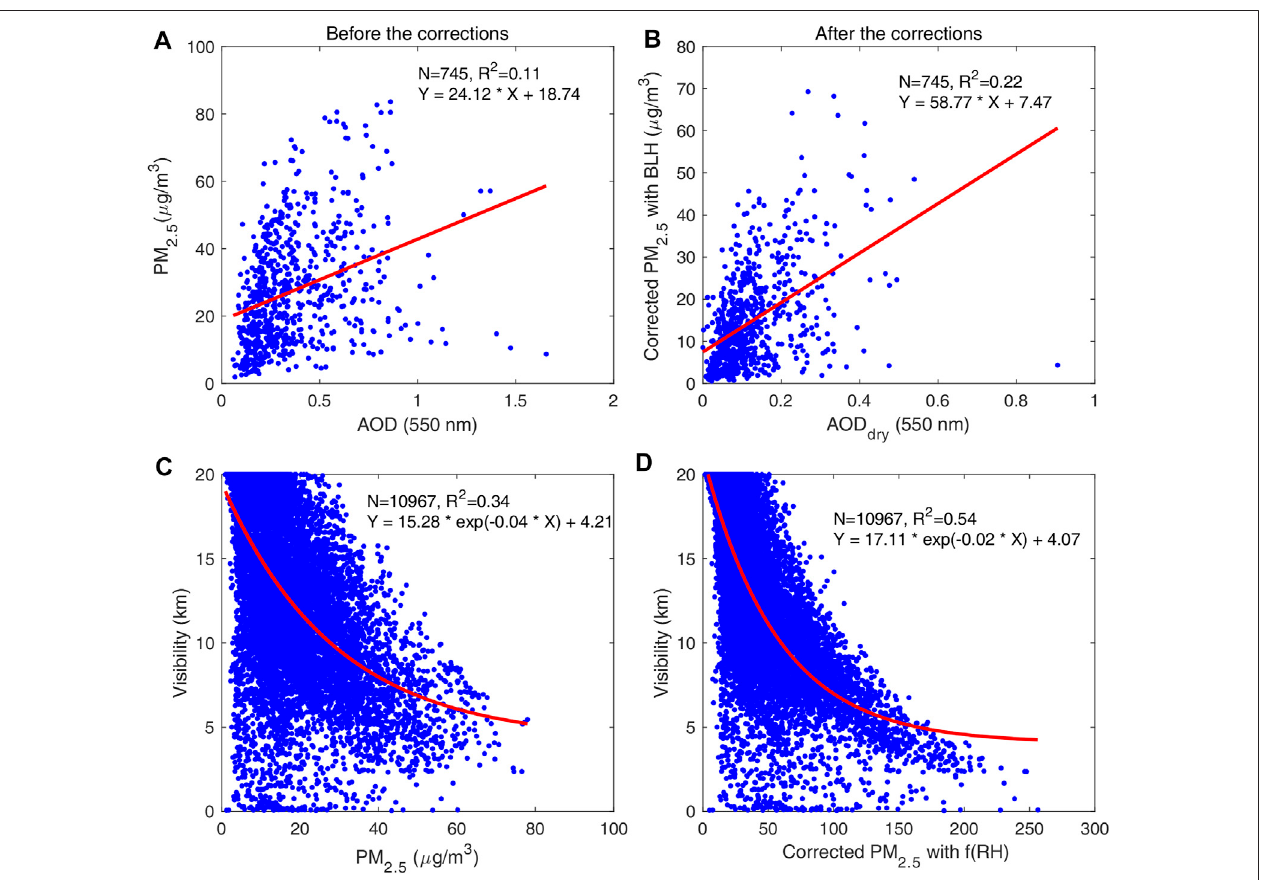
FIGURE 5 | Scatter plots of AOD vs. PM 2.5 (A,B) and PM 2.5 vs. visibility (C,D) at Xichong. The left panel is before the corrections of RH and BLH; the right panel is after the corrections of RH and BLH.